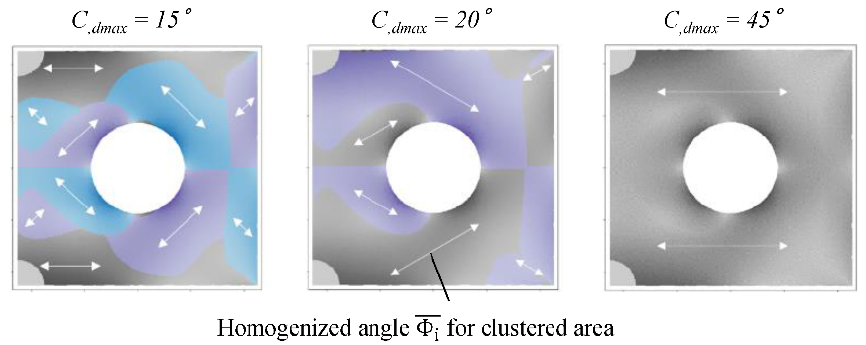
◦ , 20 ◦ , and 45 ◦ d,max = 15